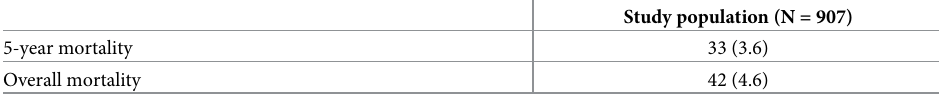
FIGO: International Federation of Gynecology and Obstetrics; RDW: red cell distribution width; RBC: red blood cells; CTx: chemotherapy; RTx: radiation therapy; ICU: intensive care unit. Values are expressed as mean ± standard deviation or n (proportion).